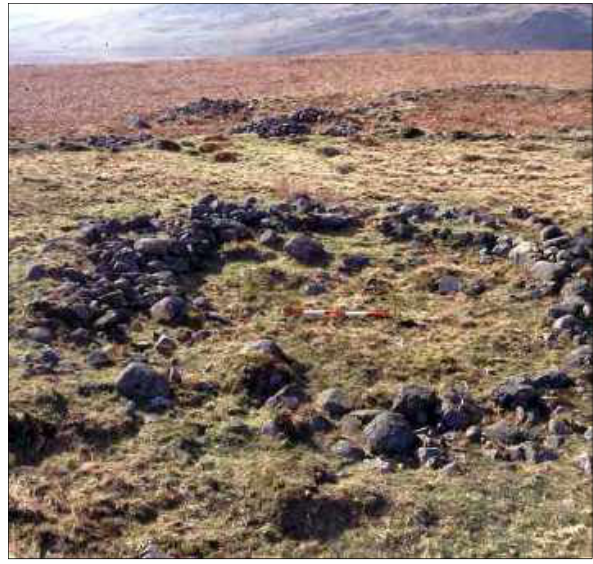
Fig 2.33 Upland enclosures and hut circles at Town Bank, Cumbria (OA